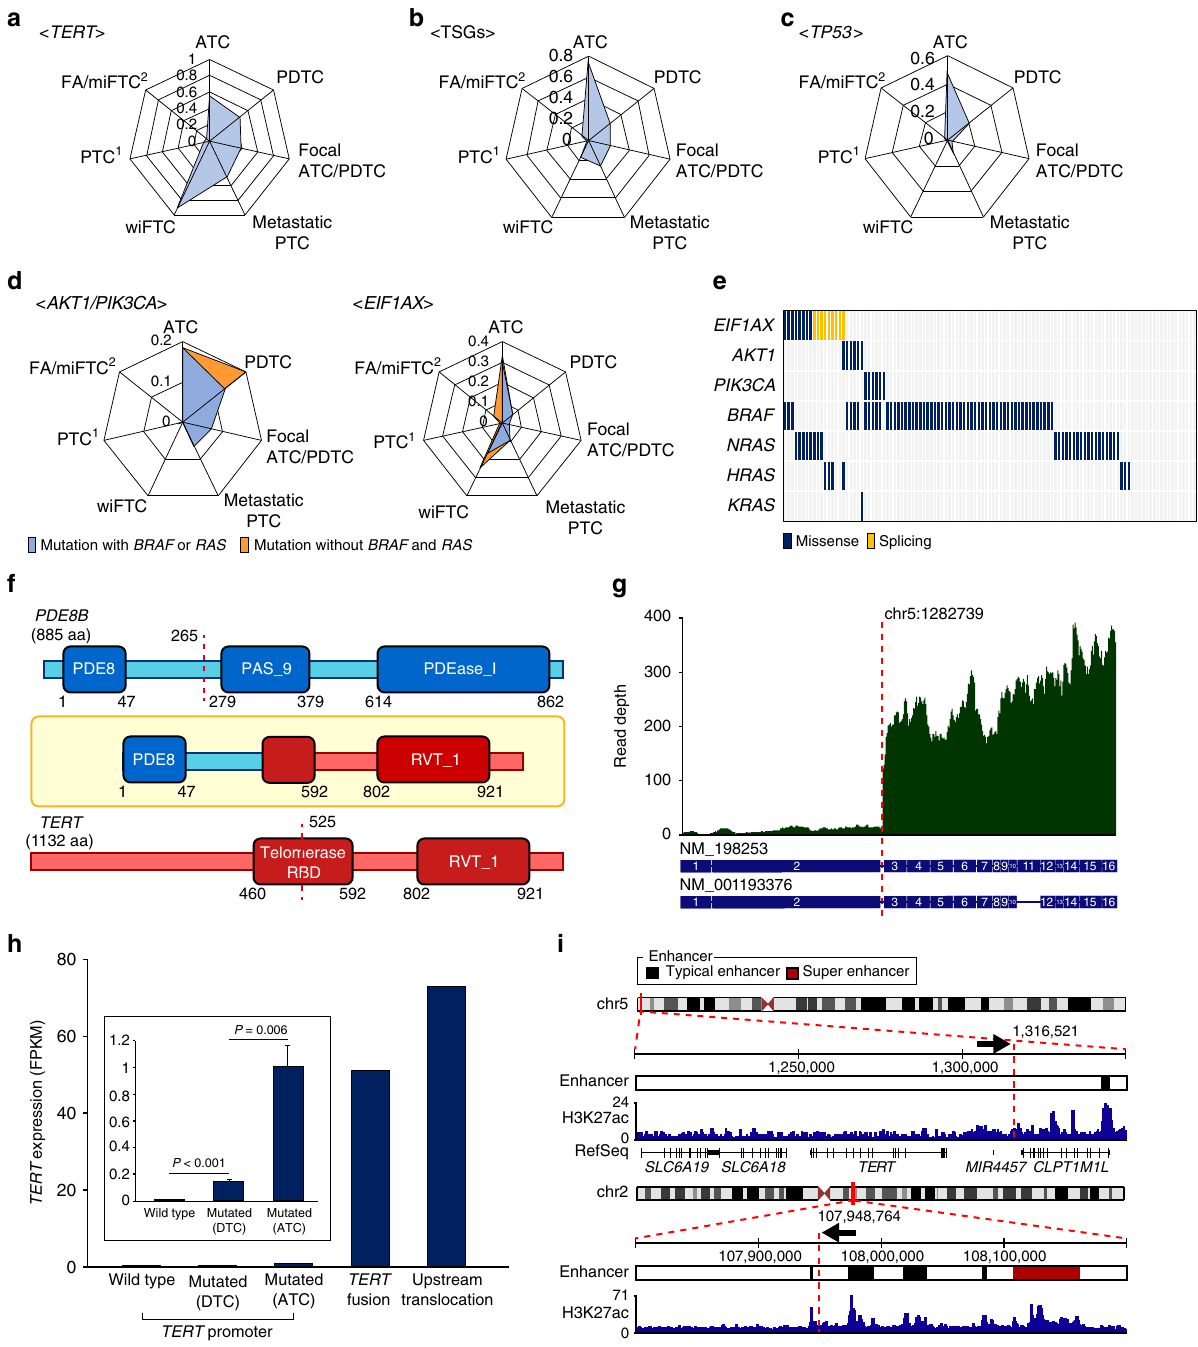
Fig. 2 Recurrently altered genes in ATC and advanced DTCs. The frequencies of recurrent gene alterations among diverse types of TC were represented by radar charts. a TERT, b TSGs, c TP53 , and d the frequencies of AKT1 / PIK3CA and EIF1AX co-mutations with BRAF V600E or RAS in diverse types of TC (blue). The mutational frequencies without BRAF V600E and RAS were also displayed (orange). e The distribution of recurrent oncogene mutations across 113 TCs. f The functional domains of PDE8B – TERT fusion. g The expression level of TERT at each exon with PDE8B-TERT fusion. h The expression level of TERT by alteration type. P -values from DESeq2 were represented. i A schematic illustration of TERT upstream translocation. The breakpoints were pointed